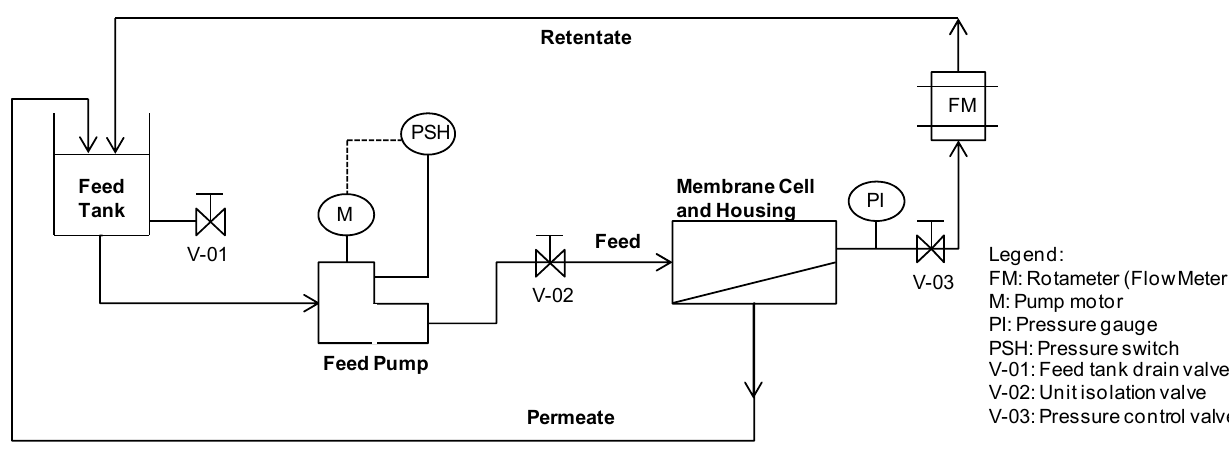
Figure 1. Schematic diagram of lab-scale NF unit